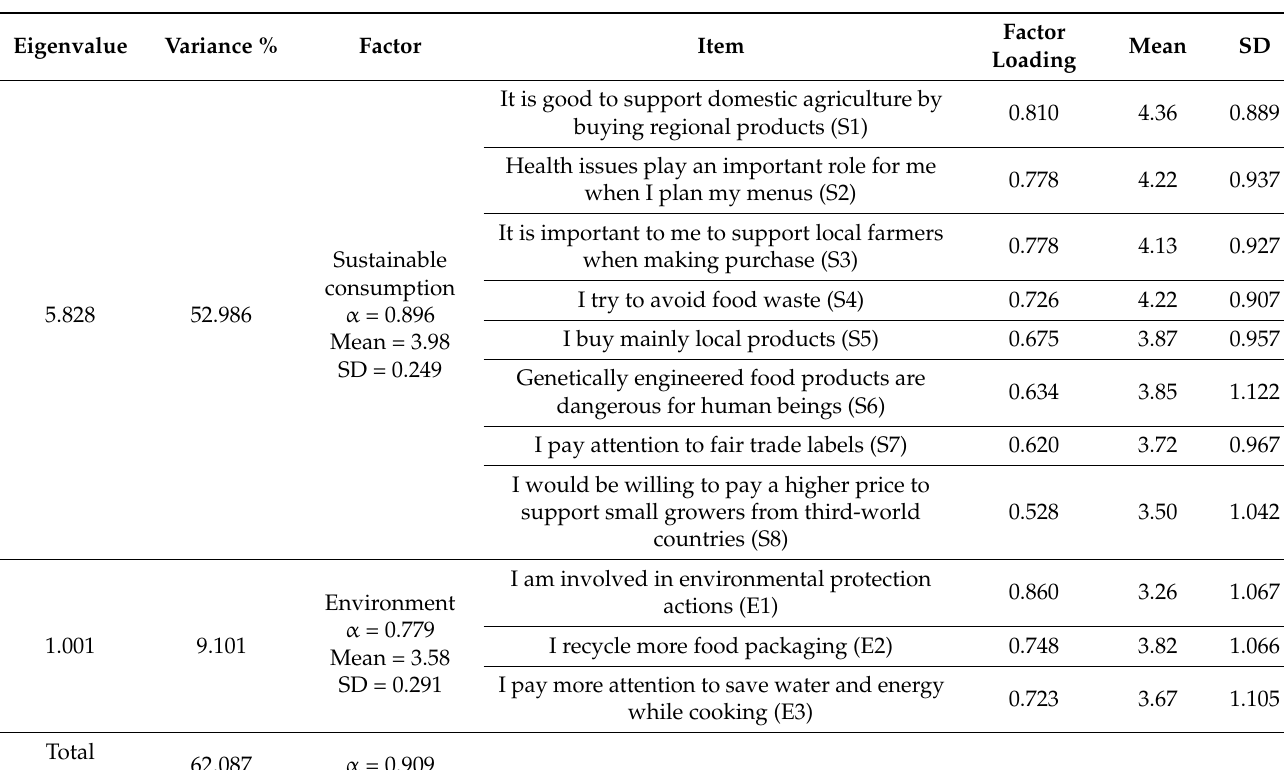
Table 2. Principal component analysis